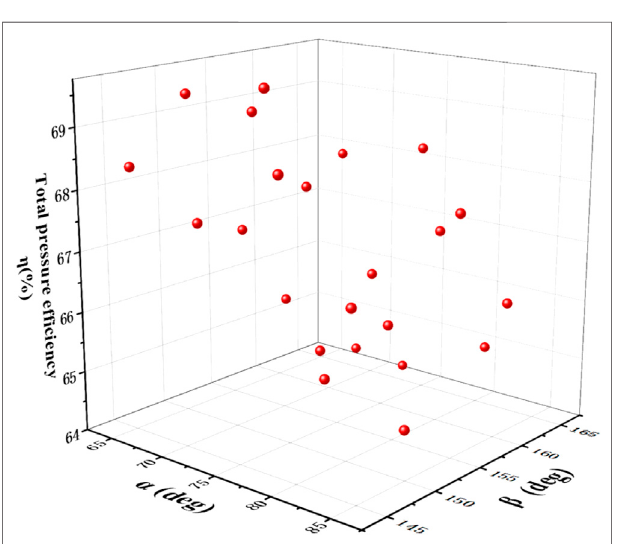
FIGURE 8 | Opt LHD test design ( Q v ).